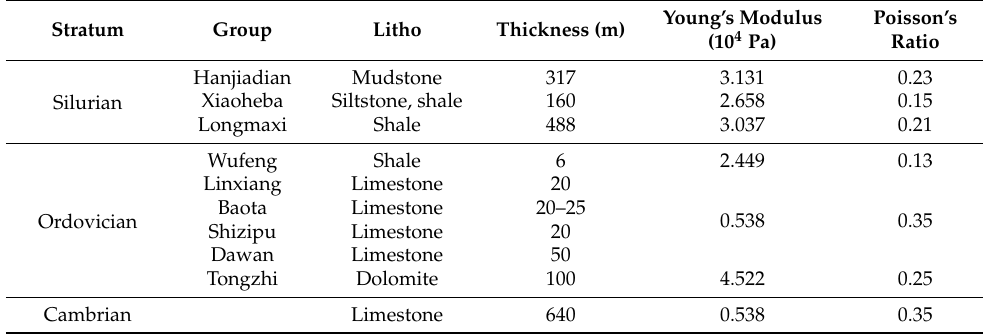
Table 1. Statistics of stratigraphic parameters in the southeast edge of Sichuan